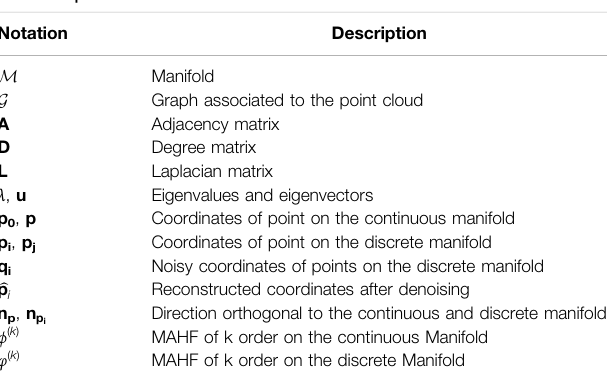
TABLE 1 | Table of main